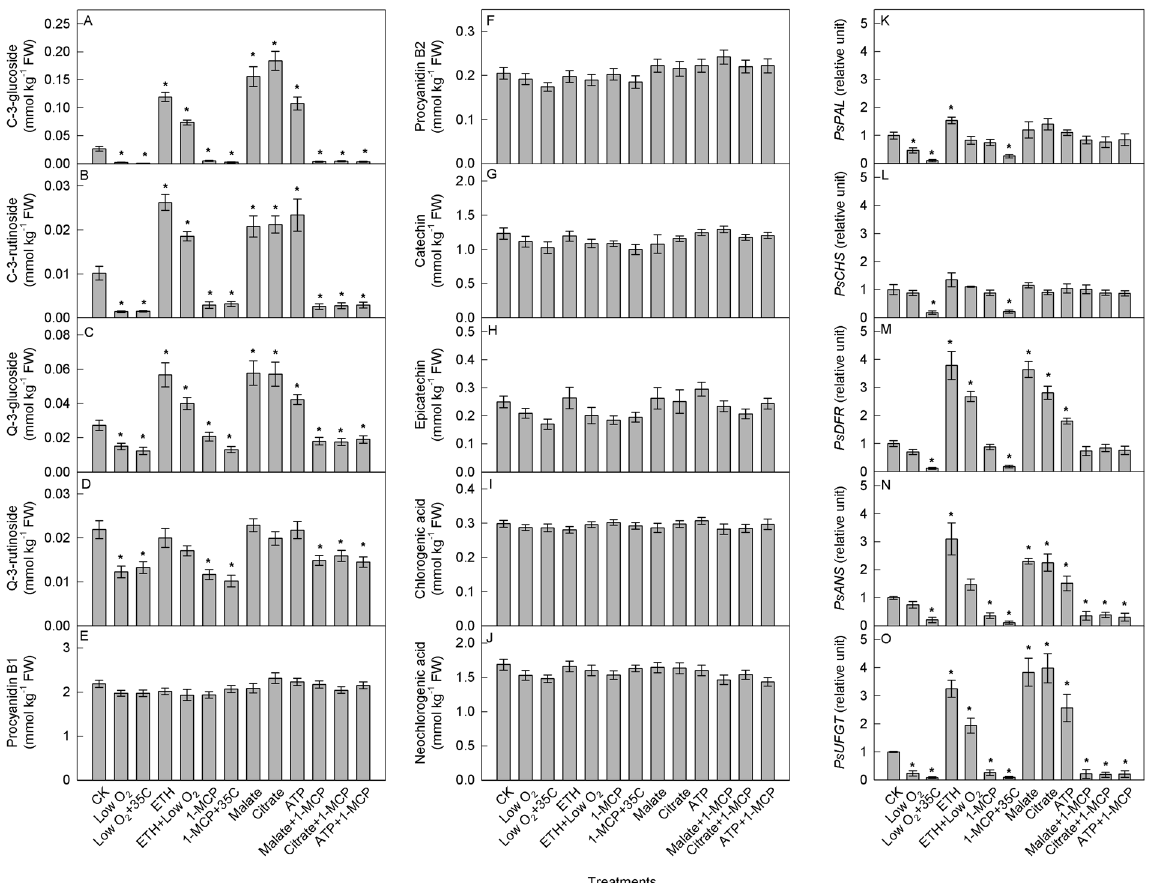
Figure 4. Concentrations of phenolic compounds ( A–J ) and transcript levels of key genes involved in anthocyanin synthesis ( K–O ) in the peel of plum fruits with different treatments in the dark. Each data point represents mean ± SE (n = 5). The asterisk indicates a significant difference between untreated and treated fruits at P < 0.05, t